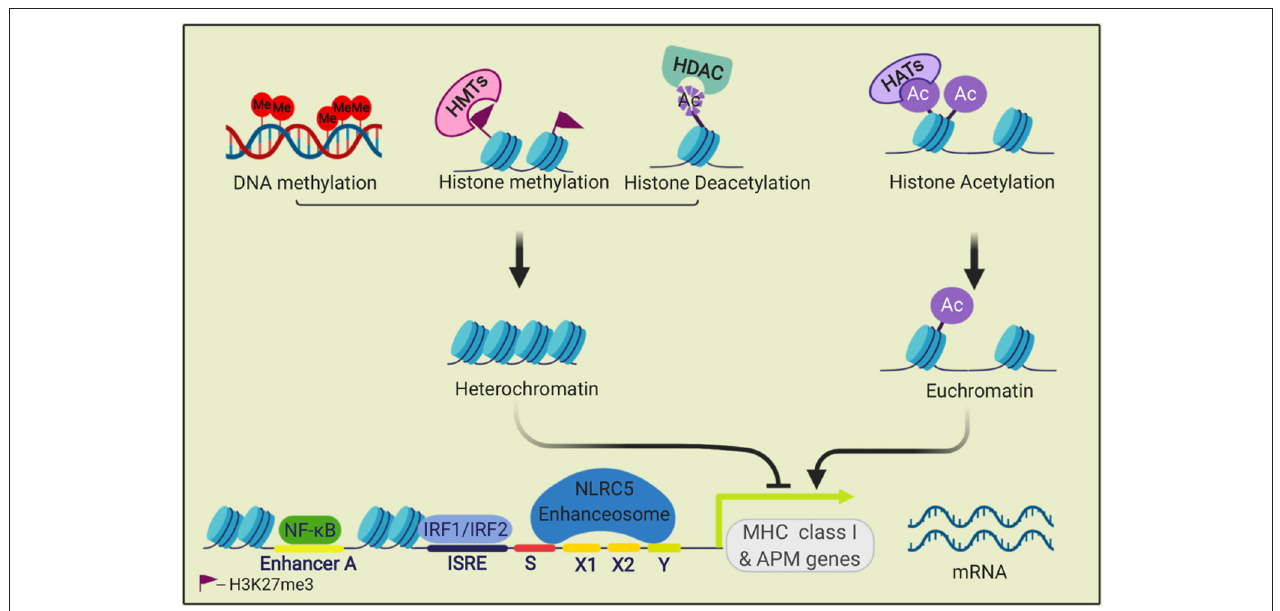
FIGURE 2 | Transcriptional regulation of MHC class I genes. The transcription factors NF- κ B, IRF1, and IRF2, and the NLRC5 enhanceosome bind to promoter and enhancer elements in the 5’ upstream sequences of MHC I APM genes and drive their transcription. This process is regulated by epigenetic modifications. Methylation of histone (H3K27me3) by histone methyltransferases (HMTs) and DNA methylation repress transcription. Histone acetyltransferases (HATs) acetylate histones, which can open the chromatin for transcription. Histone deacetylases (HDACs) can remove histone acetylation marks and silence